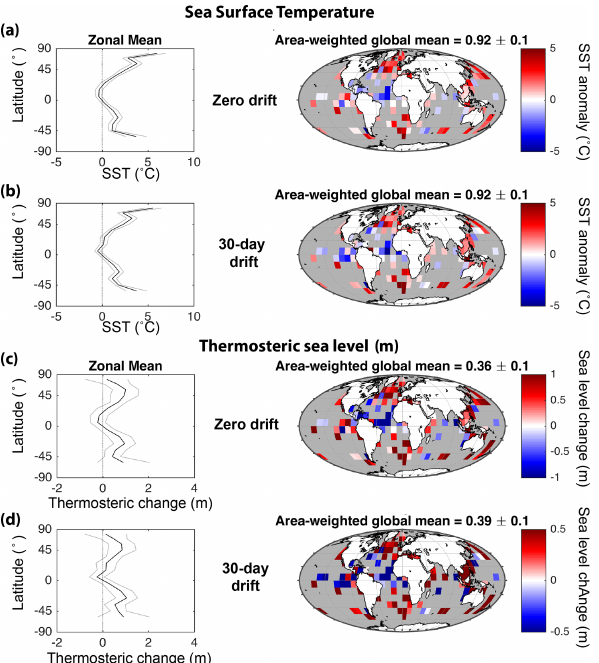
Figure 6. Global and zonal mean annual sea surface temperature (SST) anomalies and SST-derived thermosteric sea level change during the early Last Interglacial reported as uncorrected (panels a and c , respectively) corrected values, i.e. after applying 30d (pan- els b and d , respectively) temperature offsets arising from drift with ocean currents. Uncertainty for zonal average reconstructions are given at 1 σ . Here ocean warming is assumed to have penetrated to 2000m depth on average. Temperature estimates are relative to the modern period (1981–2010CE).